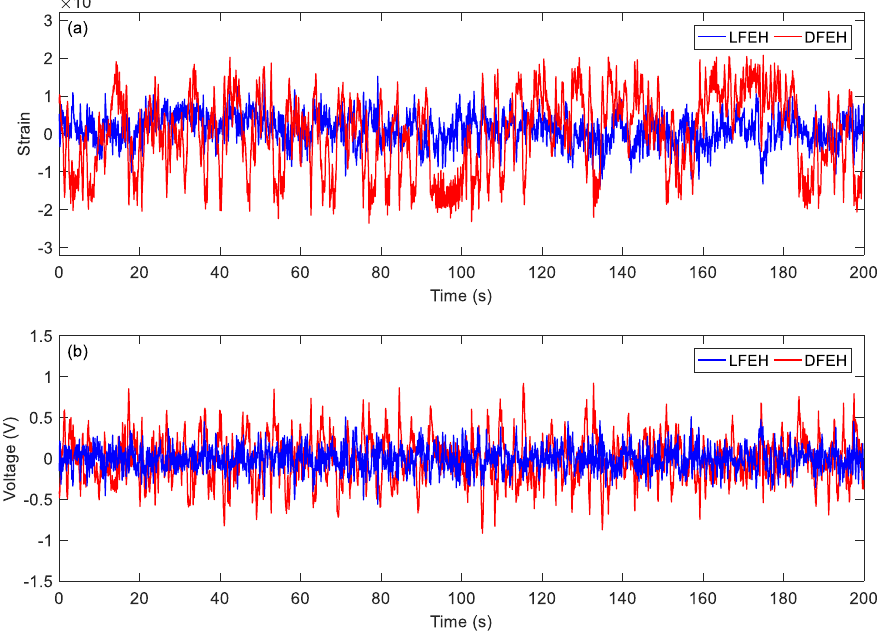
Figure 16. ( a ) Time histories of strain response, ( b ) time histories of voltage response ( v =5.5 m/s).